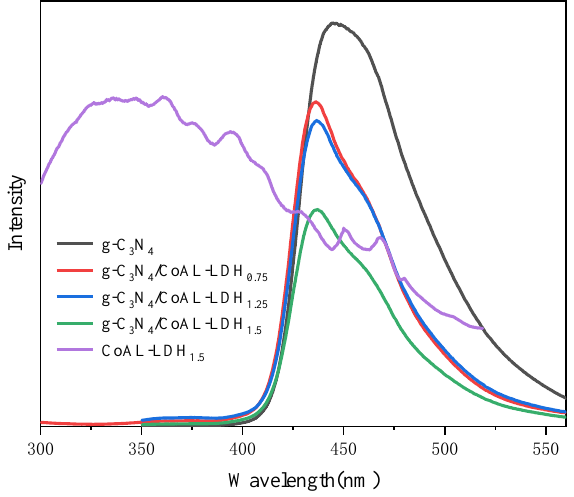
Figure 6. PL spectra of the g-C 3 N 4 , CoAl-LDH, and the g-C 3 N 4 /CoAl-LDH nanocomposites.